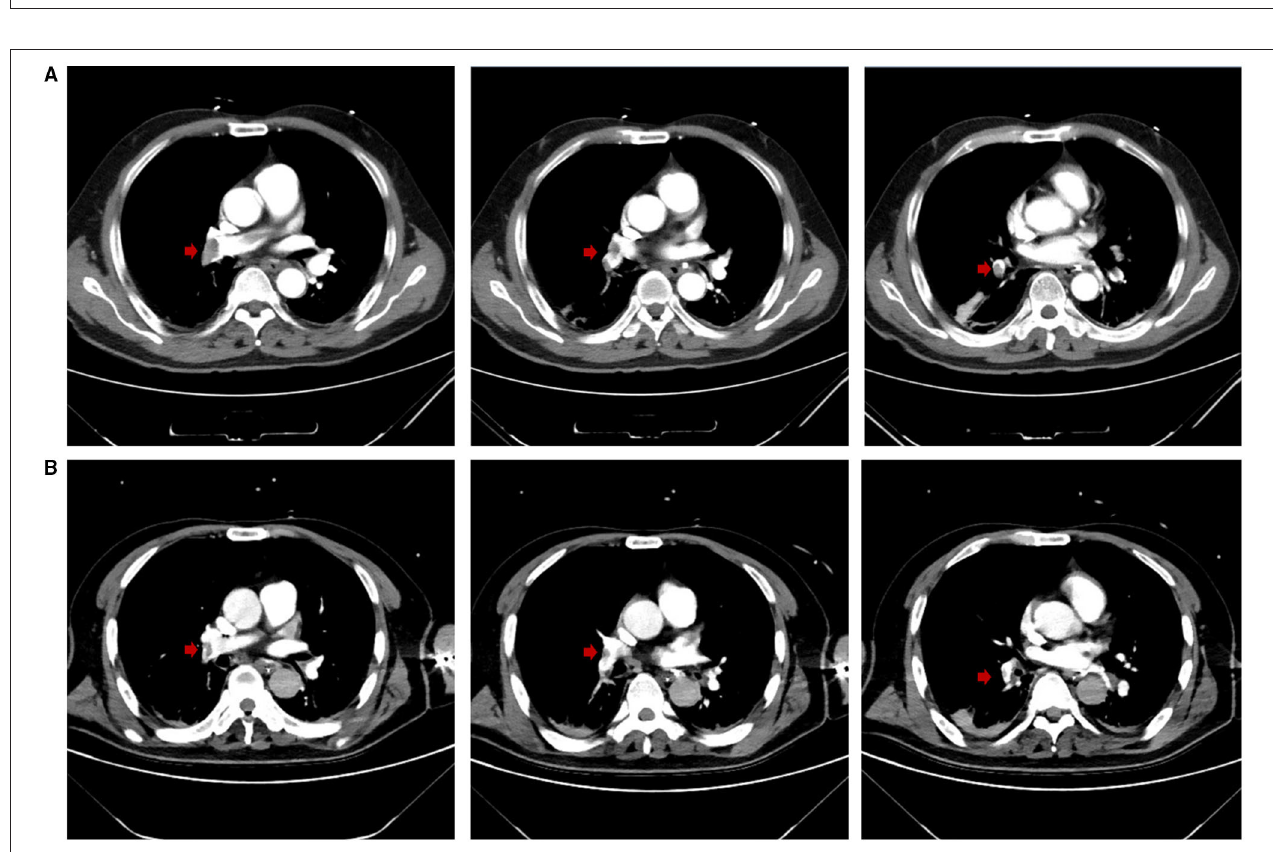
FIGURE 2 | (A) CTPA at admission demonstrated multiple embolisms in the right pulmonary trunk and right pulmonary artery branches (embolisms in the right pulmonary artery branches not shown). Red arrows highlight the locations of the emboli. (B) On Day 12, CTPA revealed reduced embolisms in the right pulmonary trunk and right pulmonary artery branches, and improved artery visualization could be observed. Red arrows highlight the locations of the